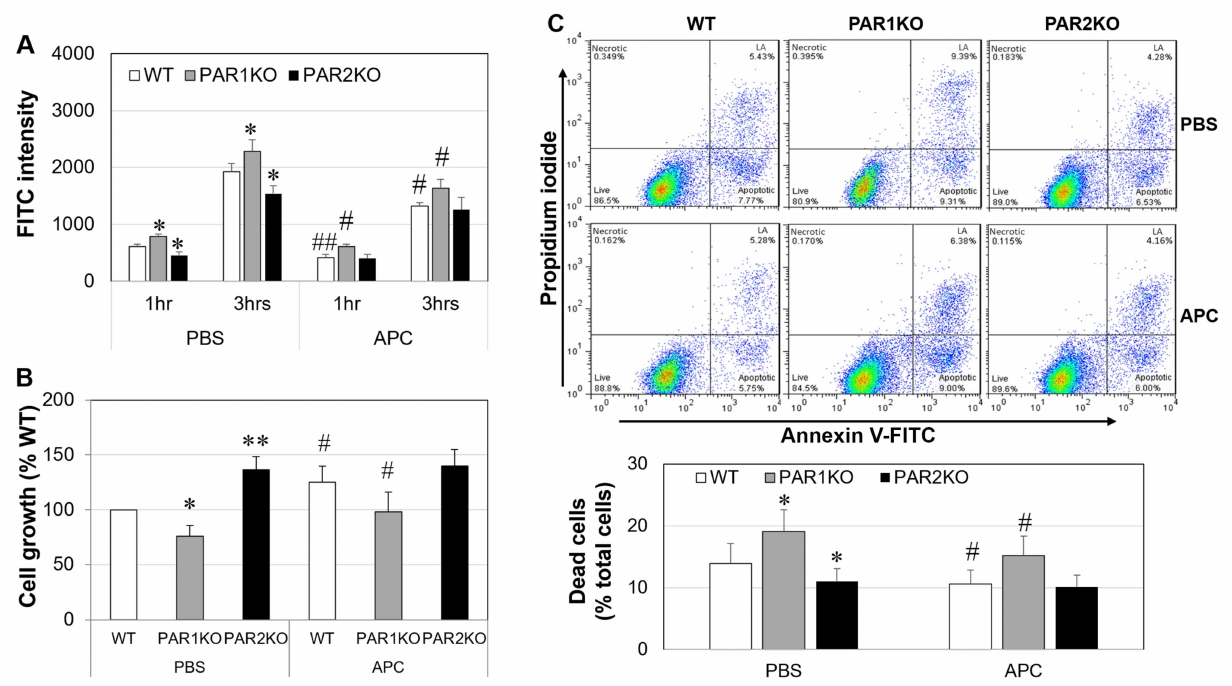
Figure 6. The effect of APC on barrier function, cell proliferation and apoptosis of mouse keratinocytes in vitro. Skin keratinocytes were isolated from newborn mice. ( A ) FITC intensity in the medium from lower wells of keratinocyte monolayers treated with APC (1 µ g/mL) for 24 h, detected by fluorescence absorbance using a spectrometer. ( B ) The growth of keratinocyte treated with APC (1 µ g/mL) for 72 h, detected by the MTT assay. ( C ) Percentage of dead cells (necrotic plus apoptotic cells) in keratinocytes treated with APC (1 µ g/mL) for 24 h, detected by double staining using propidium iodide and Annexin V-FITC and a flow cytometer. Data on graph are shown as mean ± SD ( n = 3/4 independent experiments). * p < 0.05, ** p < 0.01 vs. WT. # p < 0.05, ## p < 0.01 vs. its own